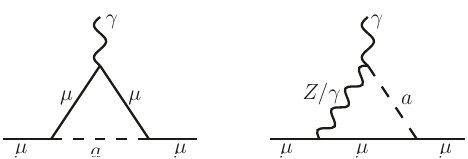
Figure 5 . One-loop diagrams contributing to the anomalous magnetic moment of the